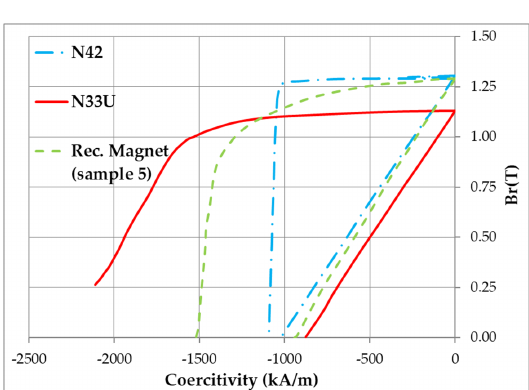
Figure 6. Magnetization reversal curve of recycled magnet (blue line, sample 5 in Table 3) in Figure6. Magnetizationreversalcurveofrecycledmagnet (greenline, sample5inTable 3)incomparison comparison with those of the initial N42 (red line) and initial high-coercivity N33U (black line) with those of the initial N42 (blue line) and initial high-coercivity N33U (red line) magnets.